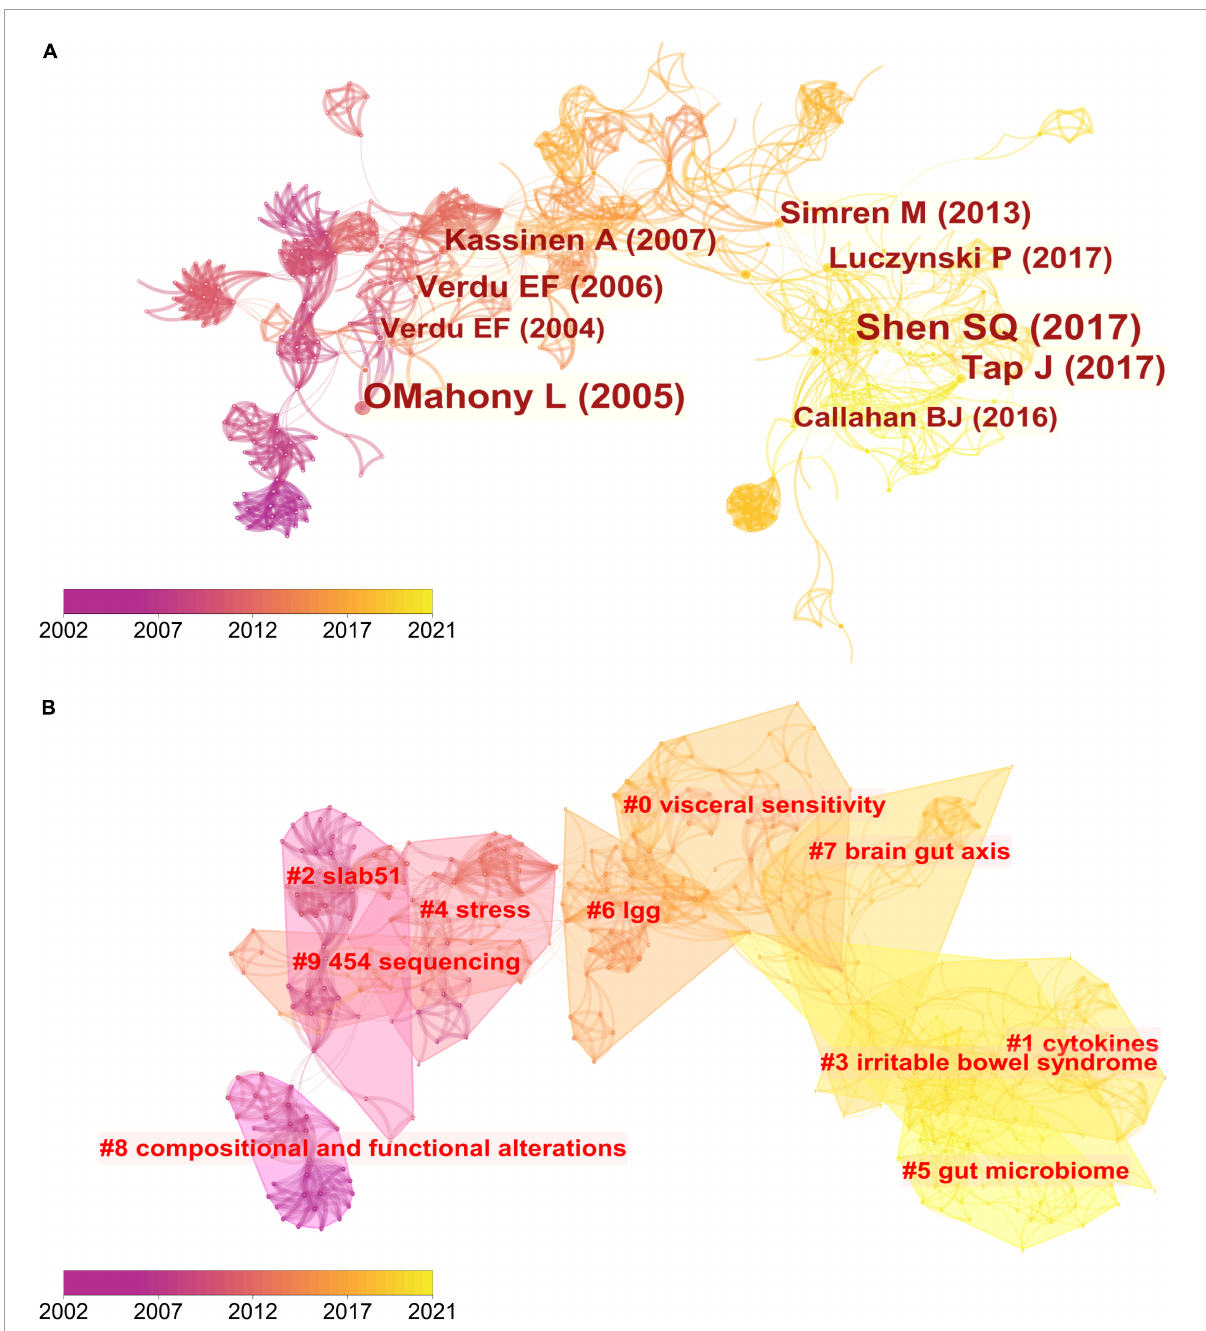
FIGURE5 Reference co-citation network analysis of publications on the links between the gut microbiota and pain between 2002 and 2021. (A) Cluster visualization of the reference co-citation map. The top 10 largest clusters of citing articles are shown. (B) Cluster visualization according to keywords generated from the references by